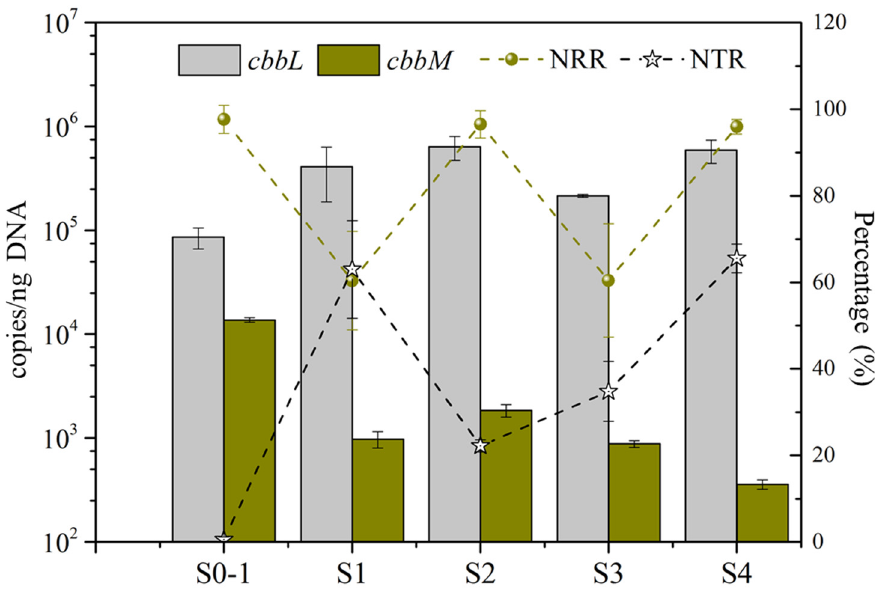
Figure 5. Abundances of gene cbbL and cbbM , as well as the nitrate-removal ratio (NRR) and nitrite- transformation ratio (NTR), during each stage.